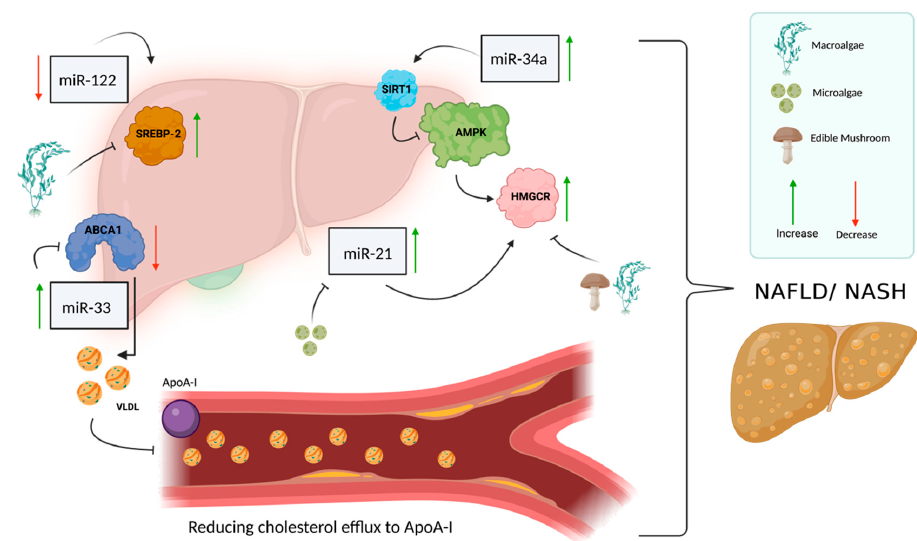
Figure 3. miRNAs involved in cholesterol metabolism and NAFLD. Several miRNAs are involved in cholesterol metabolism and NAFLD, such as miR-122, miR-34a, miR-33 and miR-21. miR-122 is responsible for the regulation of SREBP-2 in its inactive form and is normally expressed at a high level in the liver, but in NAFLD patients, there seems to be a decrease in miR-122 expression level, which causes an increase in the transcription factor SREBP-2. miR-34a has a key role in the development of NAFLD through its involvement in the dysregulation of cholesterol metabolism. miR-34a is responsible for the suppression of sirtuin 1 (encoded by SIRT1), which in turn is responsible for regulating AMP kinase (AMPK) activity, which regulates HMGCR phosphorylation. When miR- 34a levels increase, SIRT1 suppresses AMPK, which causes a decrease in HMGCR levels. As a result of this series of actions, the regulation of cholesterol metabolism is impaired, and there is an increase in cholesterol accumulation in the liver, which contributes to the development of NAFLD. miR-33 is overexpressed in the liver of NAFLD patients and functions as a regulator of lipid and insulin metabolism; when it is overexpressed, it suppresses ABCA1 expression. Suppression of ABCA1 re- sults in a reduction in cholesterol efflux to ApoA-I, which is a key player in the regulation of reverse cholesterol transport. High levels of miR-21 also characterize NAFLD/NASH patients; a high level of miR-21 causes the accumulation of fats in the liver and leads to an increase in HMGCR expression and impaired regulation of cholesterol metabolism. (Created with BioRender.com (accessed on 1 September 2022).